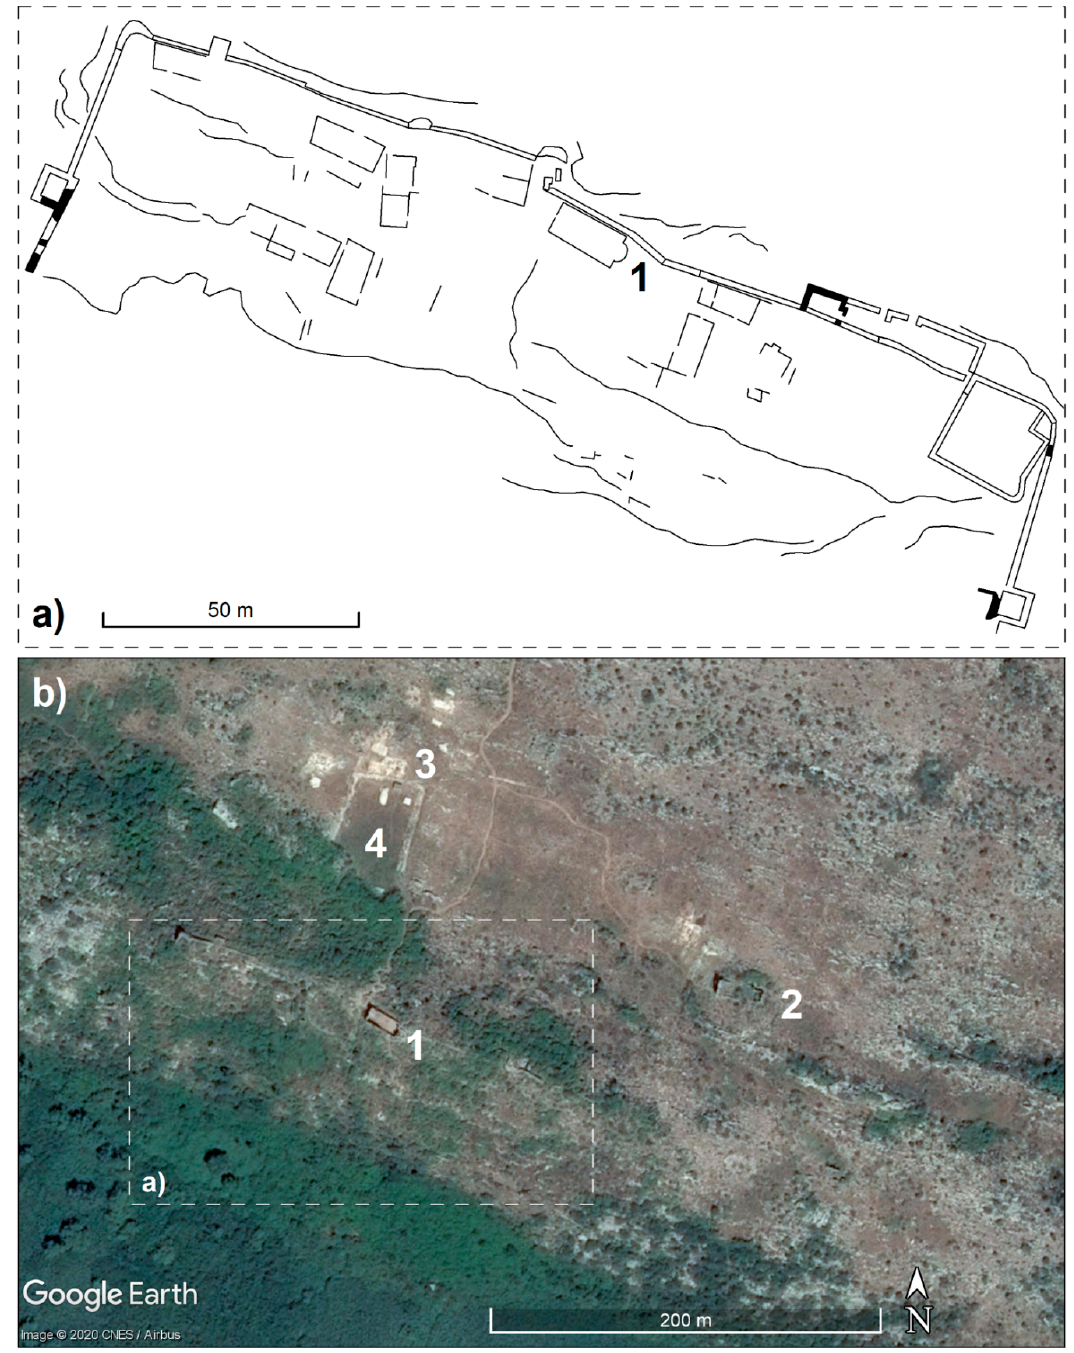
Figure 16. Sva č : the upper town plan modified by [82] ( a ), buildings 1, 2, 3 reported in Figure 17 and the surveyed area (4) on a Satellite image of Google Earth TM ( b ).